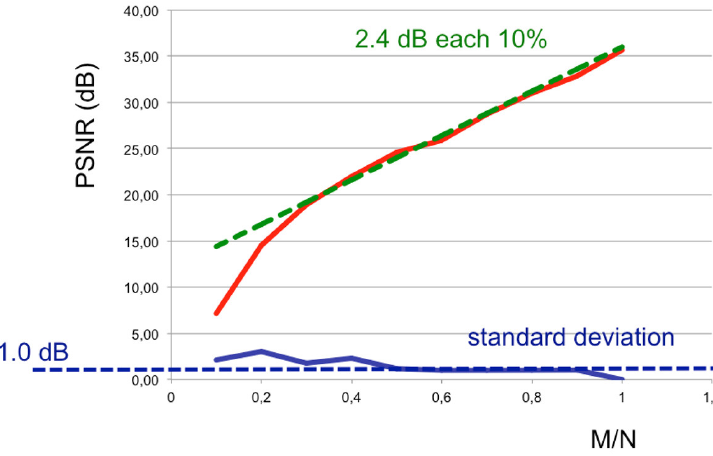
Figure 10. PSNR in function of M/N (data acquired at the experimental test site “Campus”).